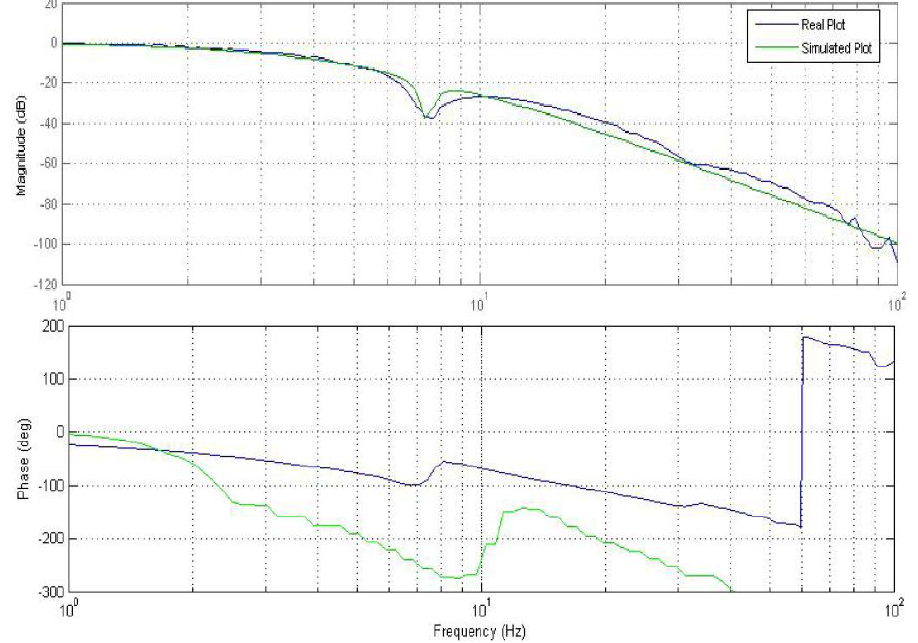
Figure 12. Bode plot for return valve